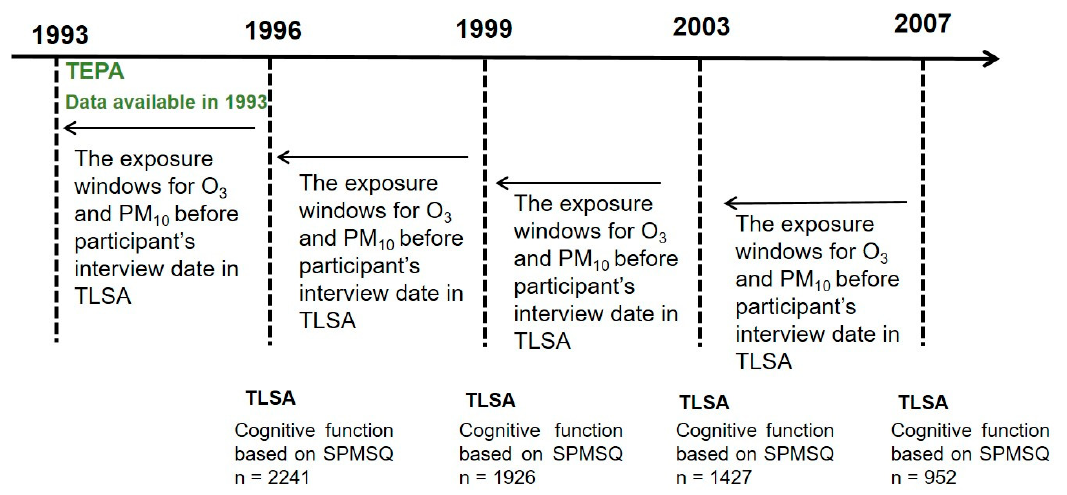
Figure 1. Flowchart of sample selection. Data source: Taiwan Longitudinal Study on Aging. Abbreviations: TEPA, Taiwan Environmental Protection Administration; TLSA, Taiwan Longitudinal Study on Aging; SPMSQ, Short Portable Mental Status Questionnaire.